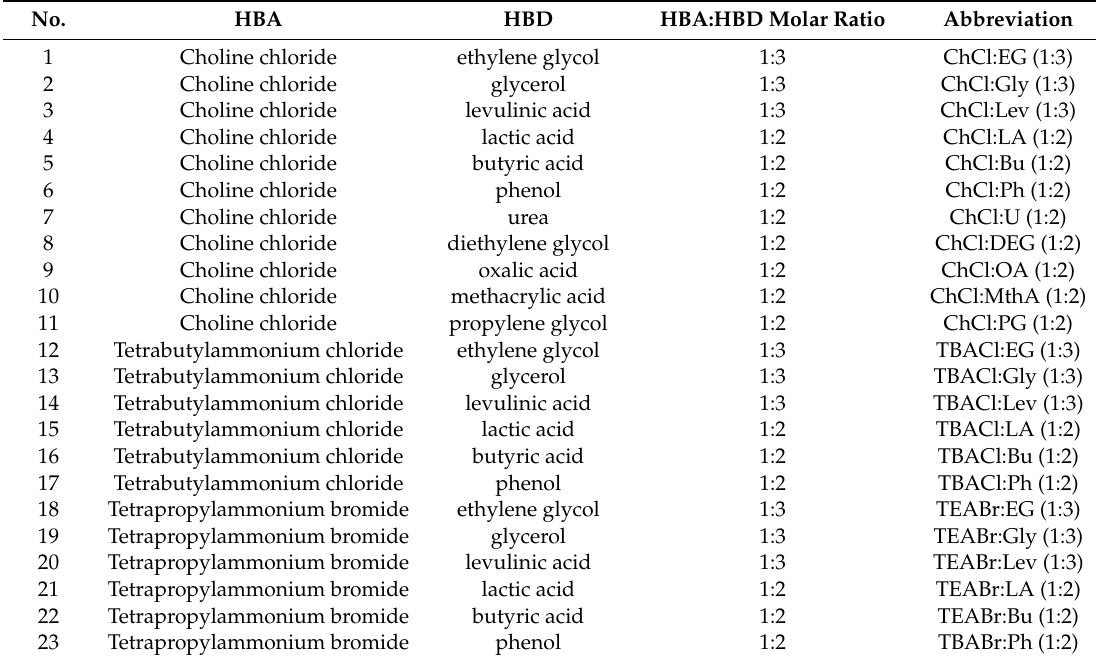
Table 2. List of deep eutectic solvents (DESs) used for the conductor-like screening model for real solvents (COSMO-RS)